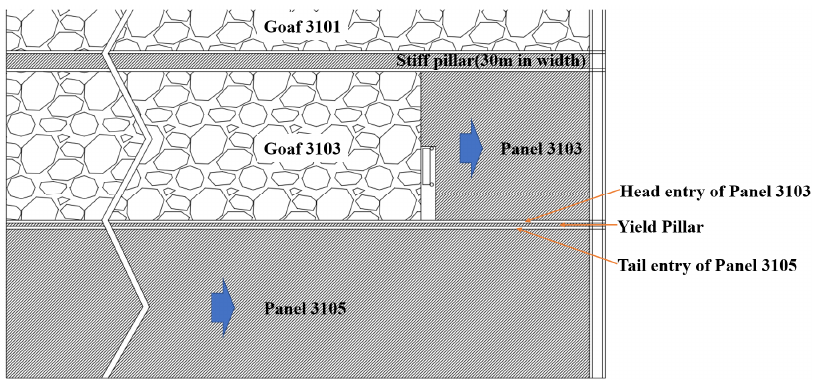
Figure 2. Plan view of local panel layout.